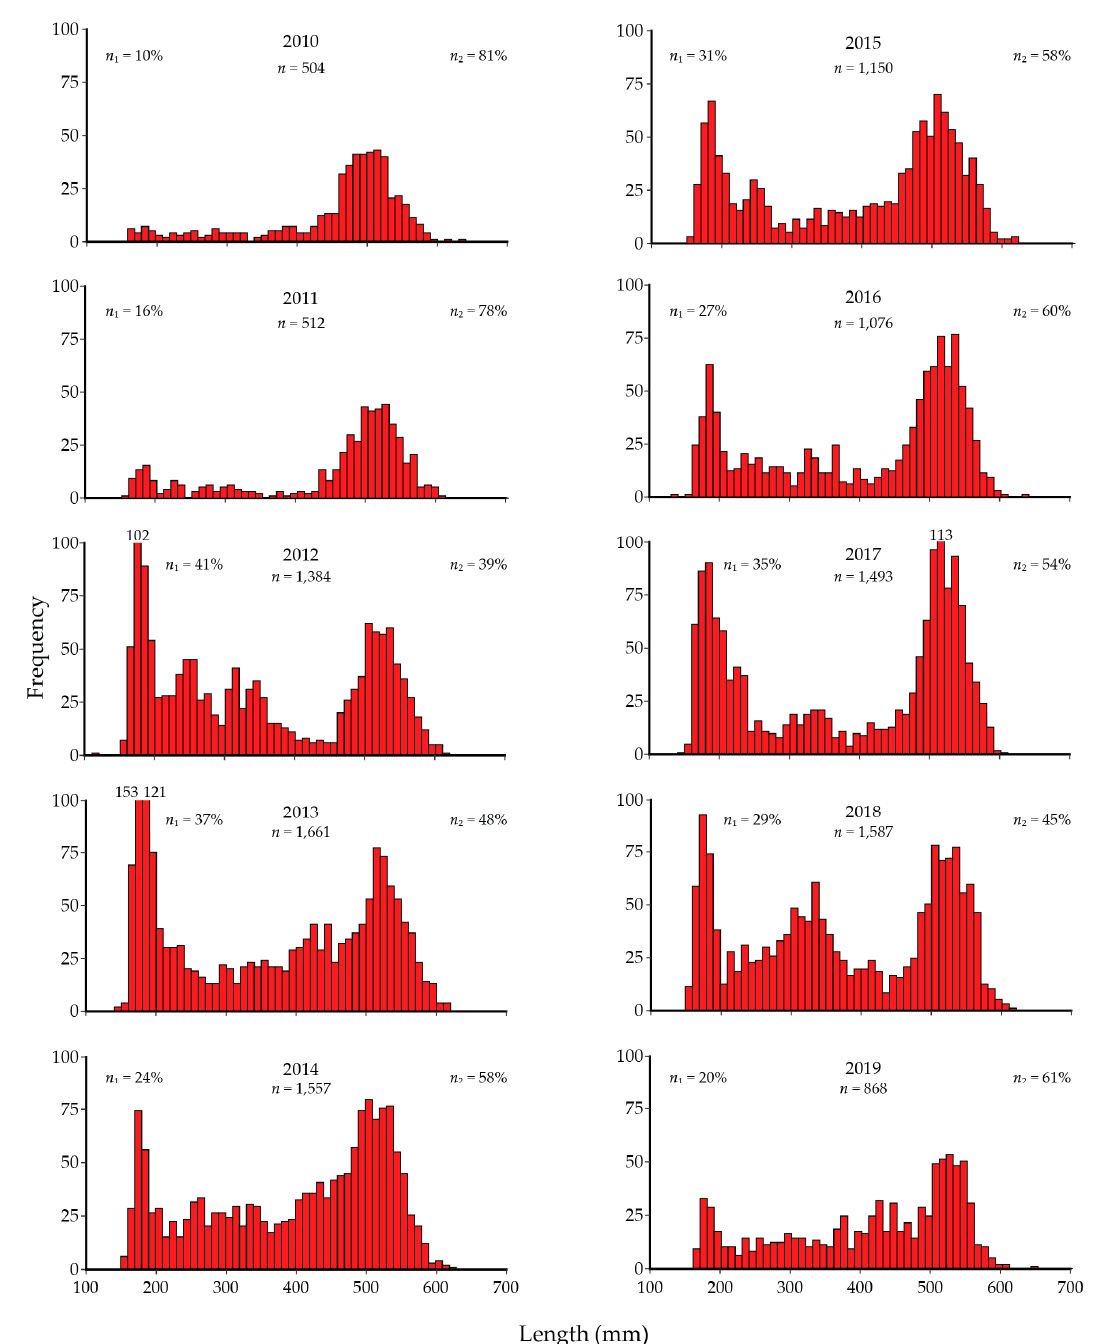
Figure A8. Length-frequency distributions of cutthroat trout sampled during annual long-term gillnetting assessments on Yellowstone Lake with total number sampled ( n ), percentage ≤ 280 mm ( n 1 ), and percentage ≥ 400 mm ( n 2 ) each year, 2010–2019.